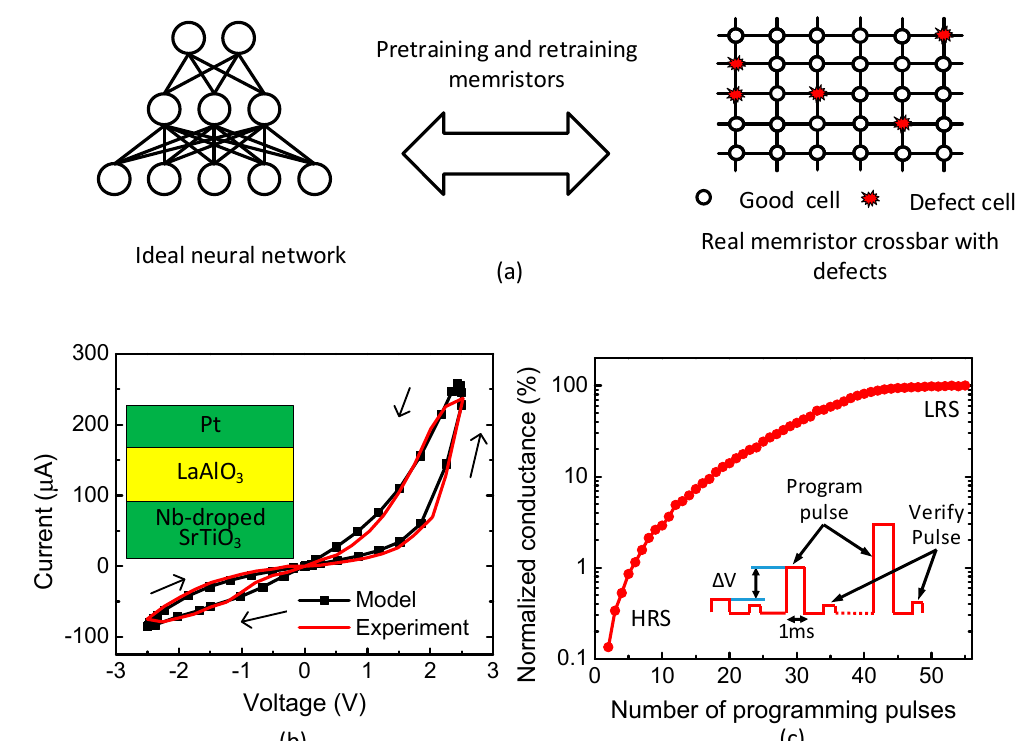
Figure 1. ( a ) The conceptual diagram of the ideal neural network versus the real memristor crossbar with defects; ( b ) the measured memristor’s butterfly curve and the Verilog-A model [11] with the cross-sectional view of the measured memristor [12], adapted from [11,12]; and ( c ) the memrisrtor’s conductance change with increasing the number of programming pulses. The inset figure shows the program-verify scheme of memristor programming based on the ISPP method of Flash memories, adapted from [13]. Vp is the programming voltage increased from 1.1 V to 2.8 V. The programming pulse width is 1 ms.